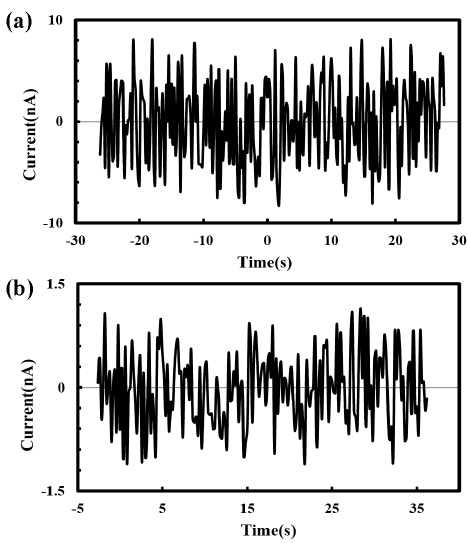
Figure 2. Noise of micro/nano current measurement system without an external load. Current amplitude: ( a ) Lower than 250 nA; ( b ) Higher than 250 nA. The applied voltage and the distance between spinneret and collector were 3 kV and 6 mm, respectively.